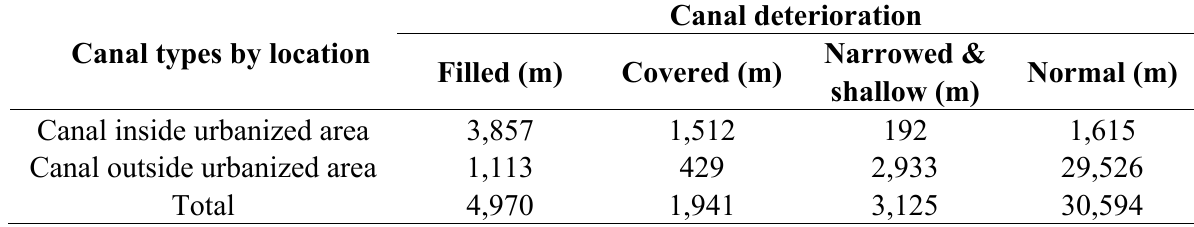
Table 2. Length of canal deterioration located inside and outside urbanized areas.